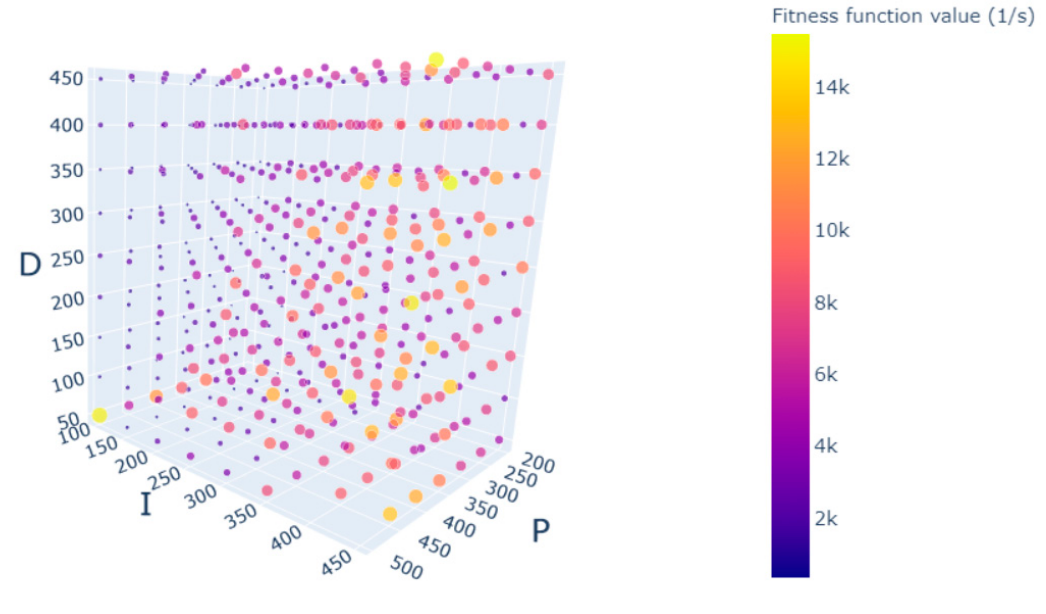
Figure 11. Grid search with fitness function values for the angular velocity of 0.1 °/s and single source driving.